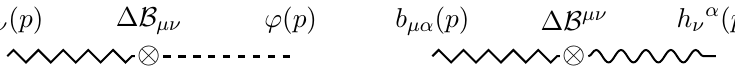
Figure 2 . Kinetic mixing